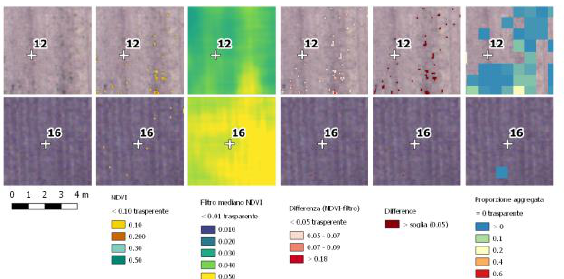
Figure 5. The sequence of steps listed in 3.3 for two ESU: RGB images over the area (column 1), overlay of full resolution pixels with NDVI>0.1 (column 2), NDVI median filter output (column 3), difference between NDVI and median filter (column 4), pixels that satisfy the conditions > 0.05 (Column 5) and FVC map aggregated over 10x10 pixels cell size (~70 cm) (Column 6).